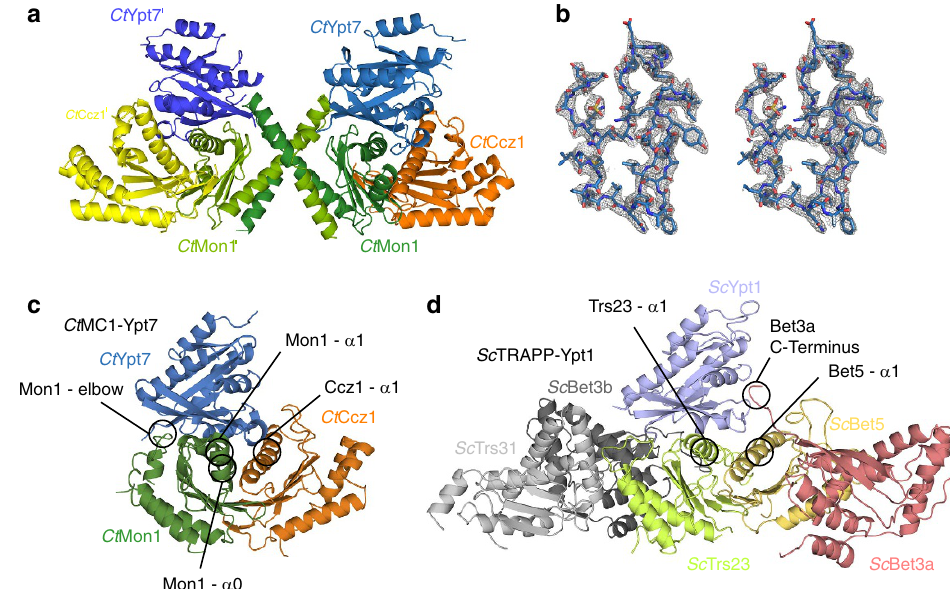
Figure 2 | Crystal structure of the catalytic Ct MC1core complex bound to nucleotide-free Ct Ypt7–N125I. ( a ) The content of the asymmetric unit is shown, comprising two copies of Ypt7 and two Mon1–Ccz1 heterodimers that interact via the domain-swapped helix a 3 of Mon1. ( b ) Stereo image of the 2F O –F C electron density map at 1.8 s contour level of the switch I, switch II and P-loop region of Ct Ypt7–N125I bound to MC1. ( c ) Complex structures of MC1 with Ypt7 where the domains’ swap was corrected to represent the likely functional unit. ( d ) Complex structure of TRAPP with Ypt1. The different interaction interfaces between GTPase and GEF are